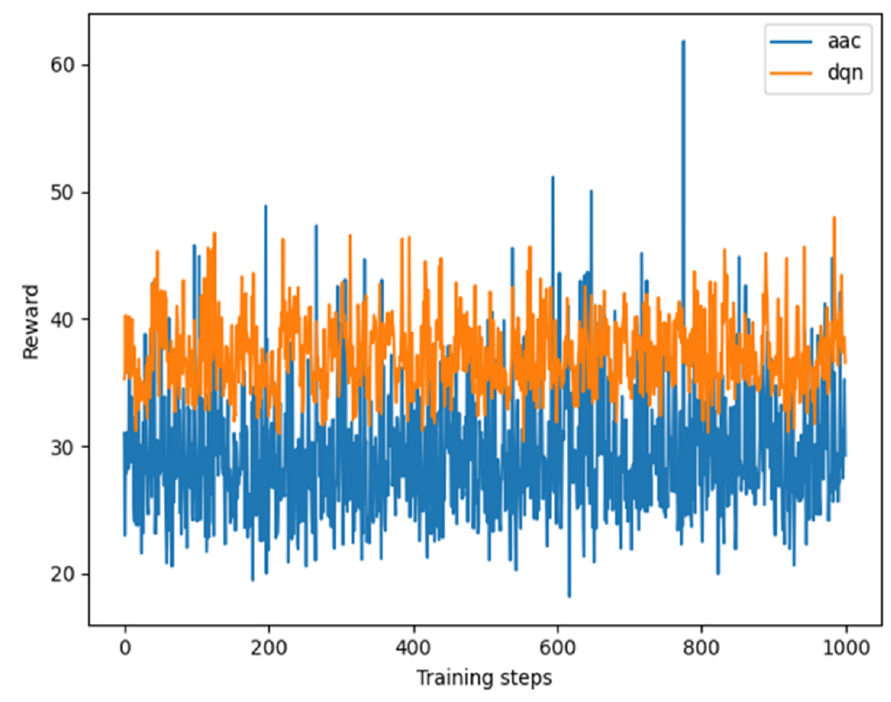
Figure 5. TSC based on improved AAC multi-leakage real-time detection algorithm and DQN algorithm.